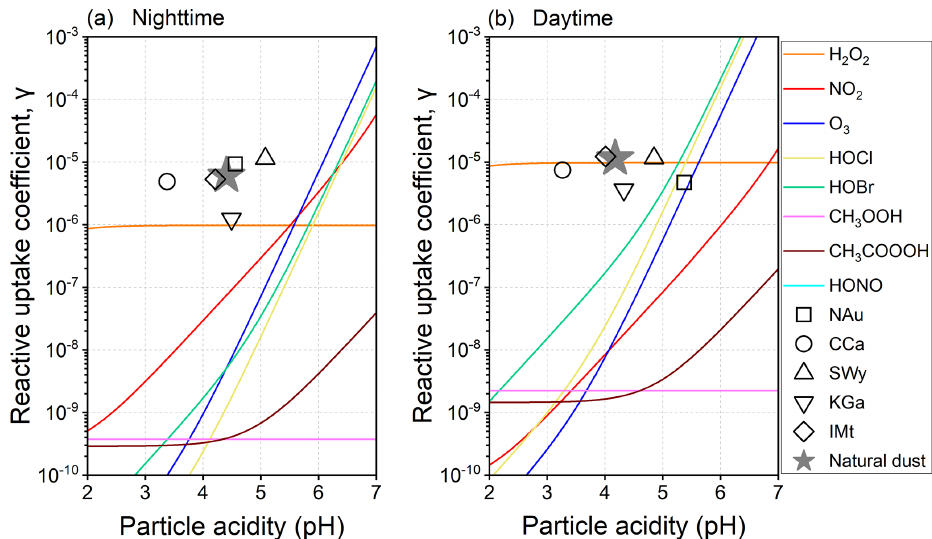
Figure 5. Particle acidity-dependent reactive uptake coefficients ( γ ) for the dust-mediated and dust-driven heterogeneous pathways. The dust-mediated pathway can be induced by the surface oxidants co-adsorbed with SO 2 , including hydrogen peroxide (H 2 O 2 ), nitrogen oxide (NO 2 ), ozone (O 3 ), hypochlorous acid (HOCl), hypobromous acid (HOBr), methyl hydroperoxide (CH 3 OOH), peroxyacetic acid (CH 3 COOOH), and dissolved nitrous acid (HONO). The dust-driven pathway can be induced by the heterogeneous drivers (transition- metal-bearing components and water-soluble ions) on natural dust and clay minerals – NAu, CCa, SWy, KGa, and